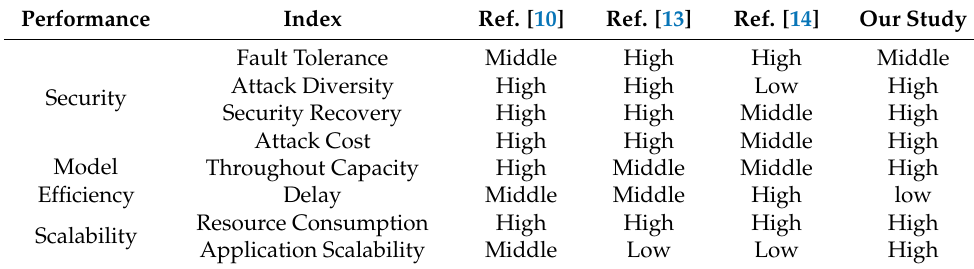
Table 5. Comparative analysis